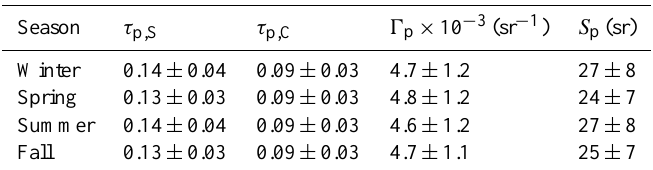
Table 1. Seasonal means ± 1 standard deviations for 2 ◦ × 5 ◦ grid cell medians. The subscripts p, S, and C appended to τ stand for particulate, SODA, and CALIOP, respectively, where τ is the AOD.